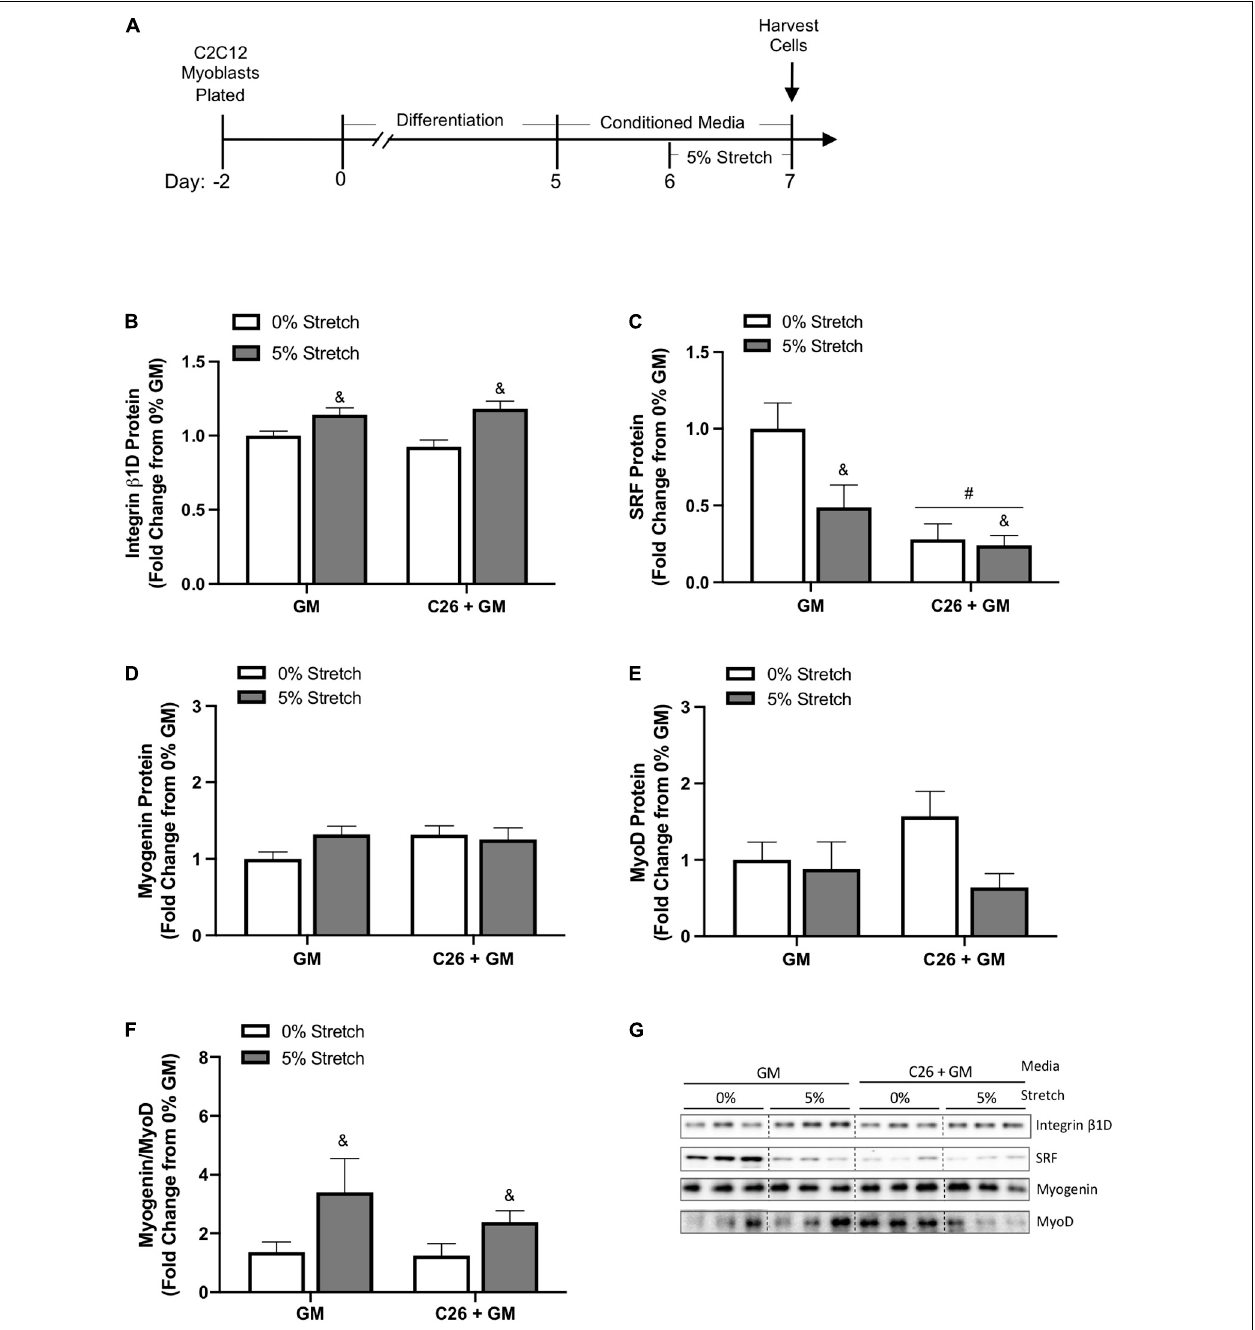
FIGURE 5 | Effects of 24-h stretch mechanical and growth-related signaling in colon-26 (C26)-treated myotubes. (A) Experiment overview: C2C12 myoblasts are plated on Uniflex membranes in growth media (GM); after 48 h at ∼ 85% confluence, differentiation media is added corresponding to day 0. Myotubes are differentiated for 5 days upon which 50% conditioned media (CM; GM or C26 + GM) is diluted with serum-free DMEM and added to wells for 48 h; myotubes are either left unstretched (0%) or stretched 5% in the last 24 h of CM incubation. Immediately after stretch, cells are harvested for protein. Western blotting analyses of (B) integrin β 1D ( n = 9/group), (C) serum response factor (SRF) ( n = 9/group), (D) myogenin ( n = 6/group), and (E) MyoD ( n = 6/group) protein expression. (F) Ratio individual protein expression of myogenin, a marker of terminal myoblast differentiation, to MyoD, a marker of myoblast proliferation and initiation of differentiation ( n = 6/group). (G) Representative Western blotting images; dashed line represents different areas of the same gel. Data are presented as means ± SEM as a fold change from GM 0% stretch. Two-way ANOVAs were performed to determine differences. & Main effect of stretch, # main effect of C26 + GM. Statistical significance set at p ≤